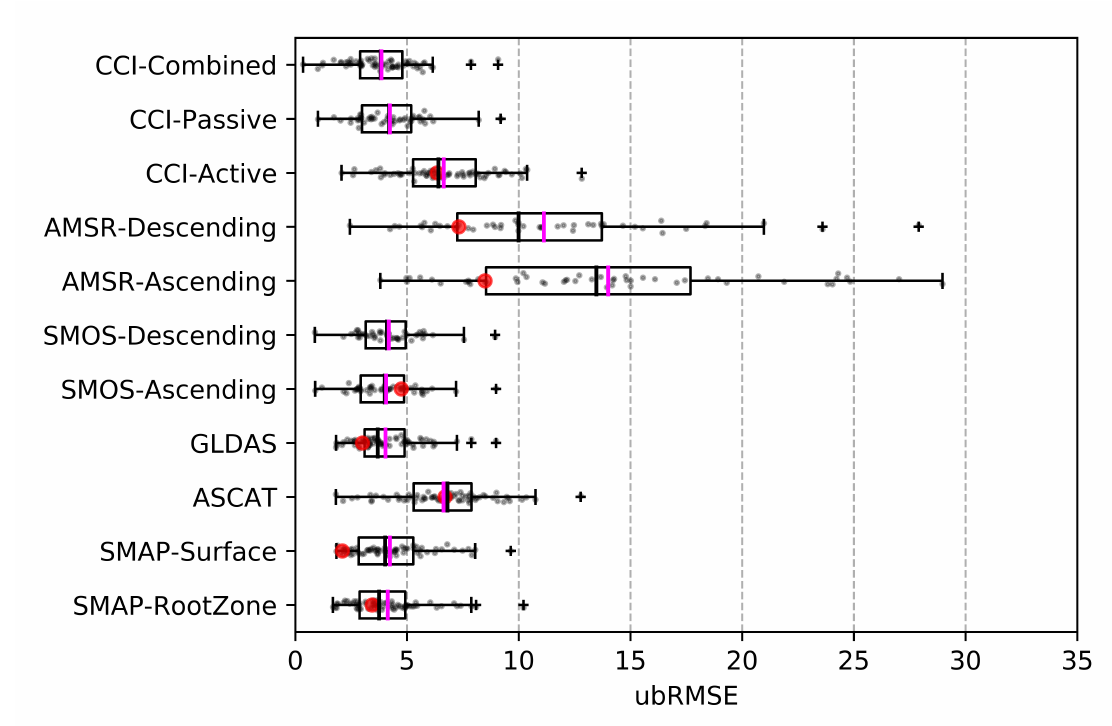
Figure 6. Box and whisker plots showing ubRMSE values between the satellite products and the CRNP’s in the COSMOS database. Red points show the results for Çakıt Basin CRNP pink lines show the mean values and + signs depict outliers.